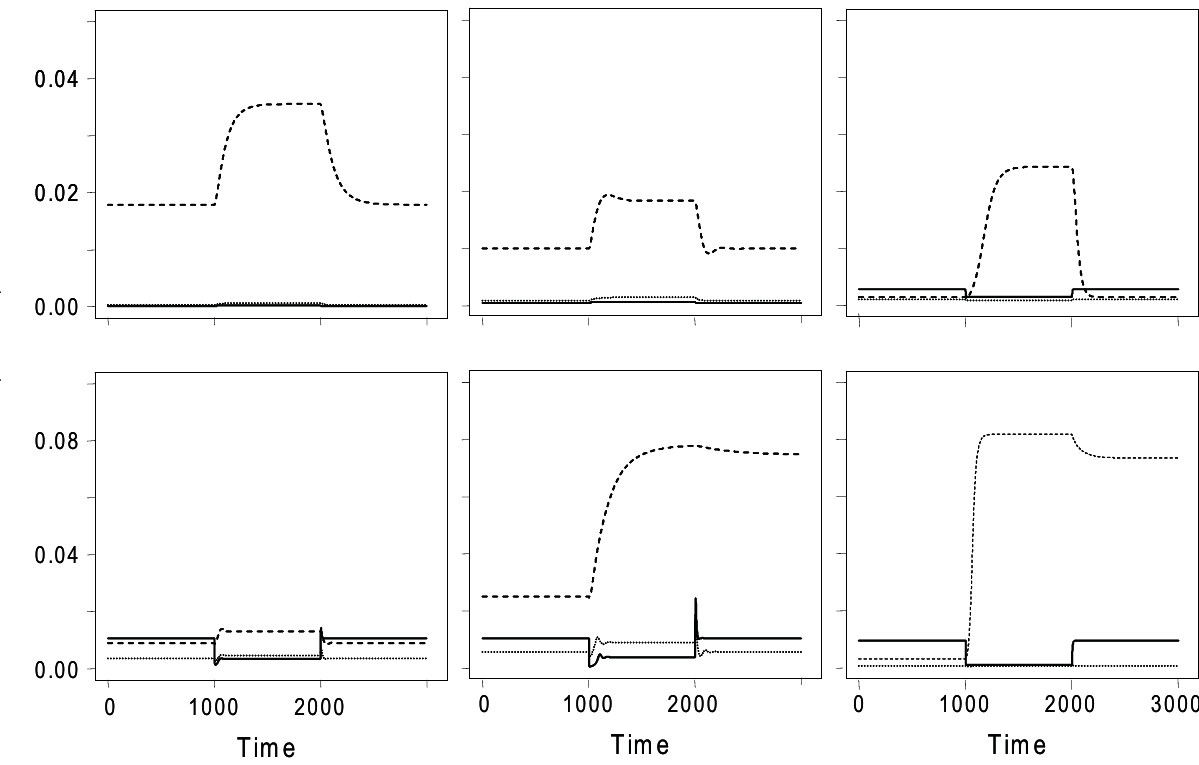
Figure 3. Diverse taxis mechanisms. Time course of active effector concentration for the most frequent and unique pathways obtained from selected evolutionary simulations that are run under different environmental conditions (see main text). Each panel displays dynamics for a specific pathway structure shown in the inset. The system is allowed to equilibrate for 1,000 timesteps at the background basal stimulus level. A stimulus of one is added at time 1,000 and removed at time 2,000. Pathway response to such stimuli given on top of a selected basal level is shown in different line types (basal level is 0, 1, and 2, respectively, for solid, dotted, and dashed). Pathways shown in the upper panels are from simulations with periodic boundary conditions and fluctuating stimulus source, while those shown in the lower panel are from simulations with non-periodic boundary conditions and fixed stimulus source. Kinetic parameters for these pathways are given in Dataset S1.